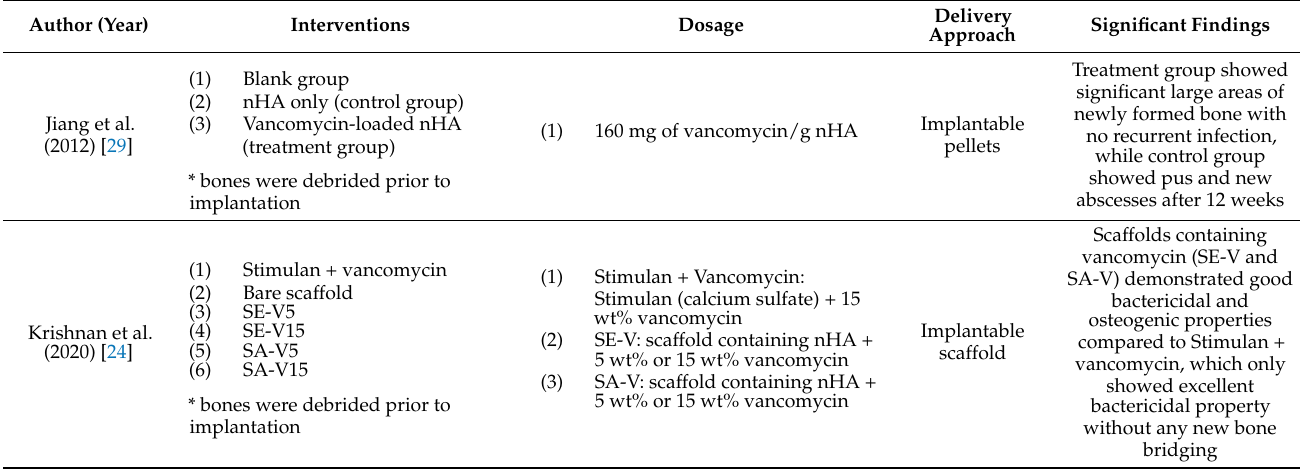
Table 4. Application of nHA for delivery of